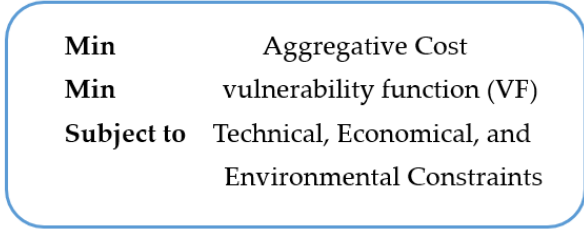
Figure 2. Holistic bi-objective model.